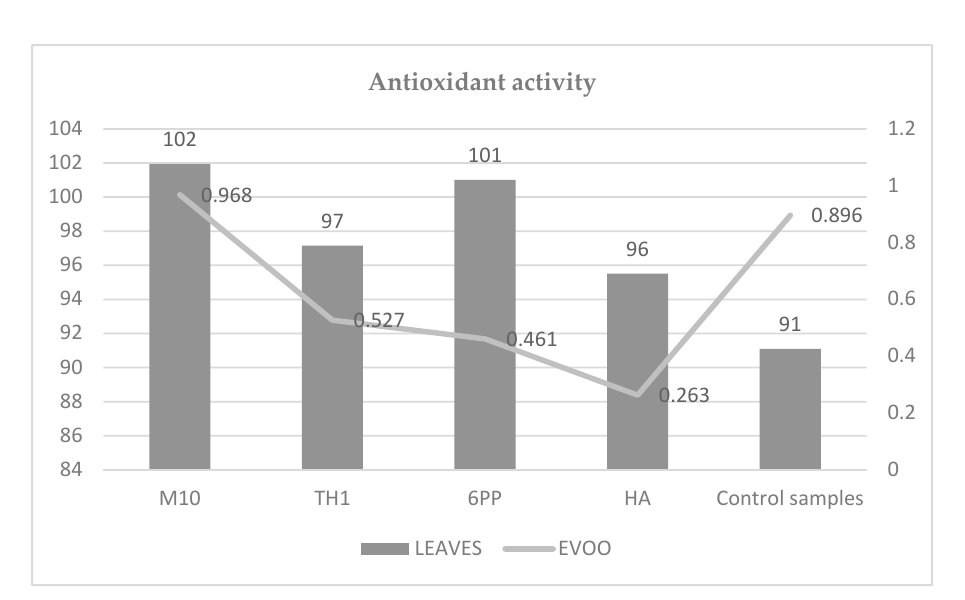
Figure 1. Antioxidant activities by analyzing samples ( mmol Trolox/kg ).